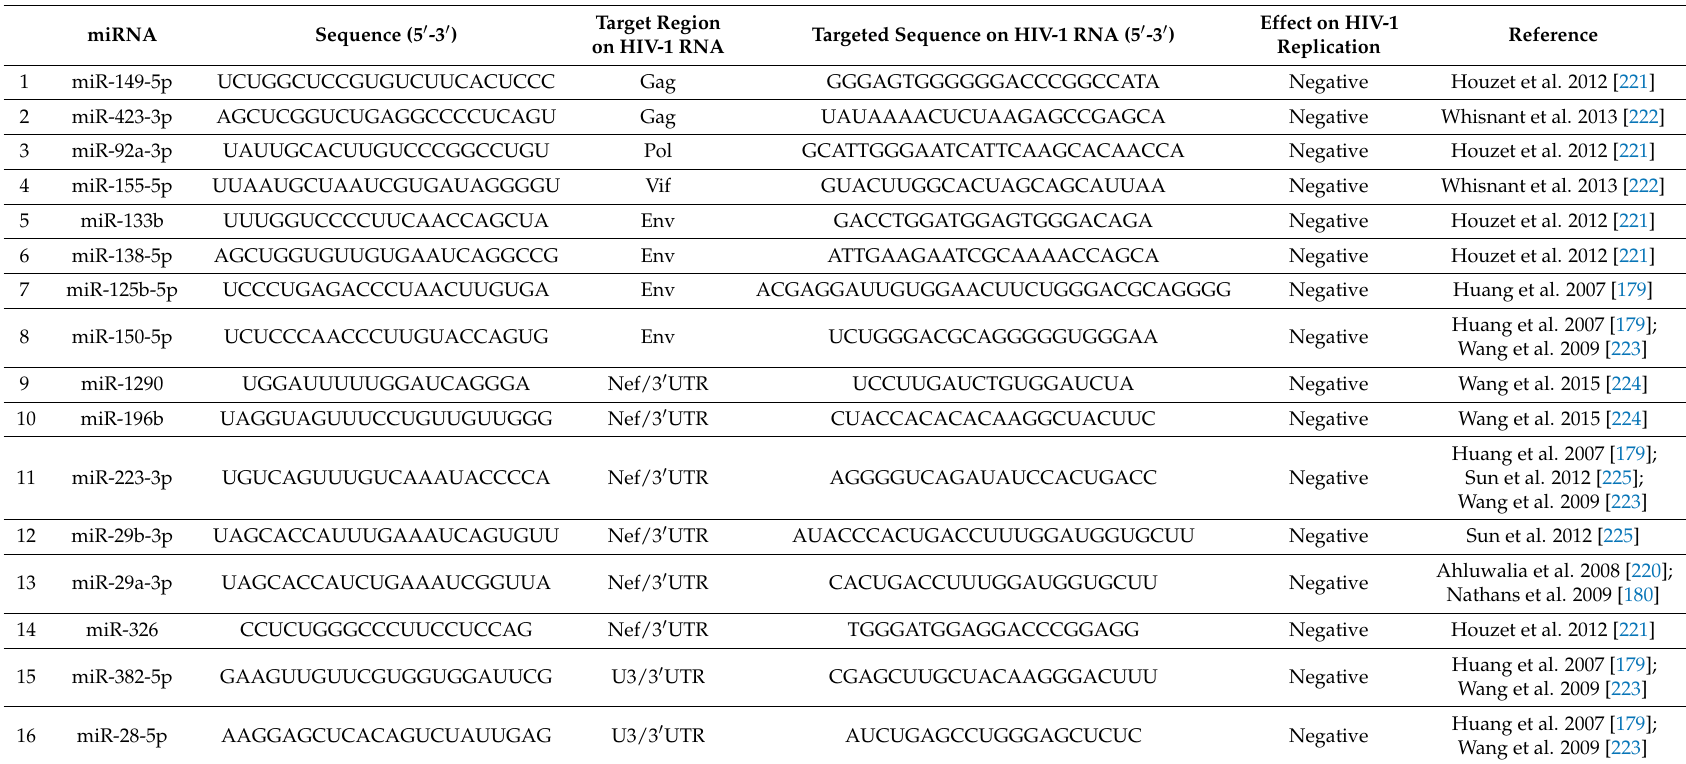
Table 1. Details of cellular miRNAs reported to target HIV-1 RNA, and discussed in this review.